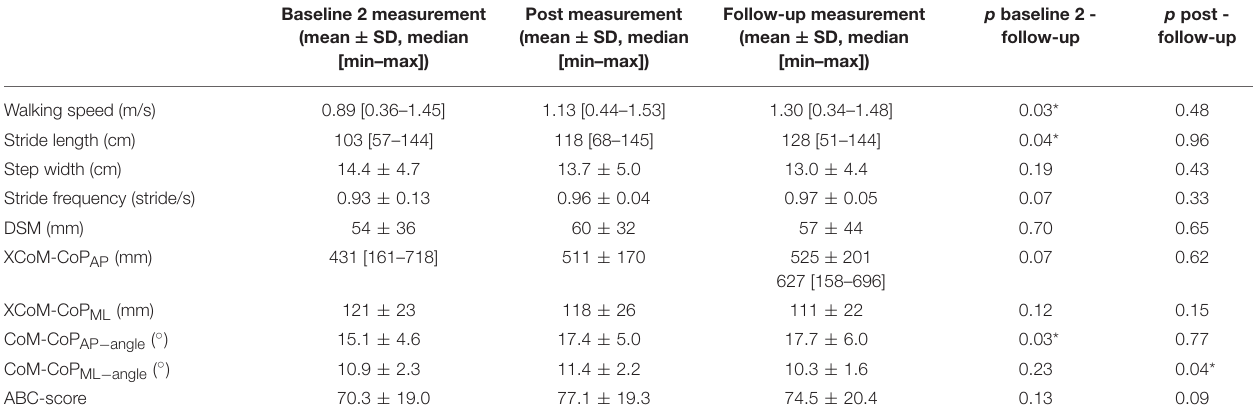
TABLE 3 | The spatiotemporal gait parameters, gait stability measures and balance confidence in the baseline 2, post and follow-up measurement ( N =